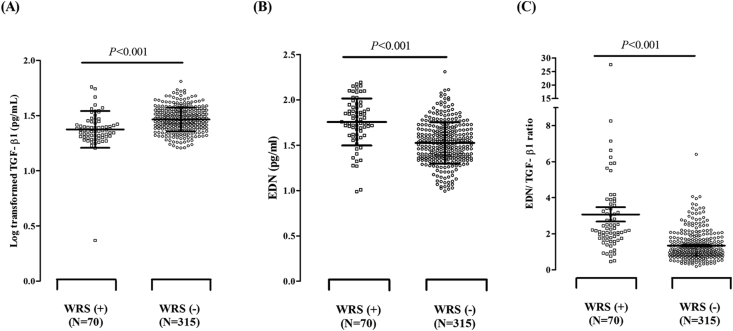
Comparison of serum TGF-β1 (A), EDN (B) levels and the EDN/TGF-β1 ratio (C) between the WRS+ and WRS- groups. Log-transformed data are presented as mean ± SD. P values were analyzed by the unpaired Student's t-test. EDN, eosinophil-derived neurotoxin; TGF-β1, transforming-growth factor β1; WRS, work-related symptoms